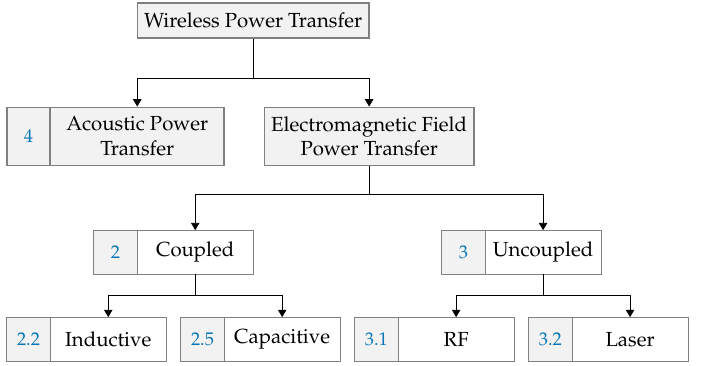
Figure 1. Categories of wireless power transfer systems, including section